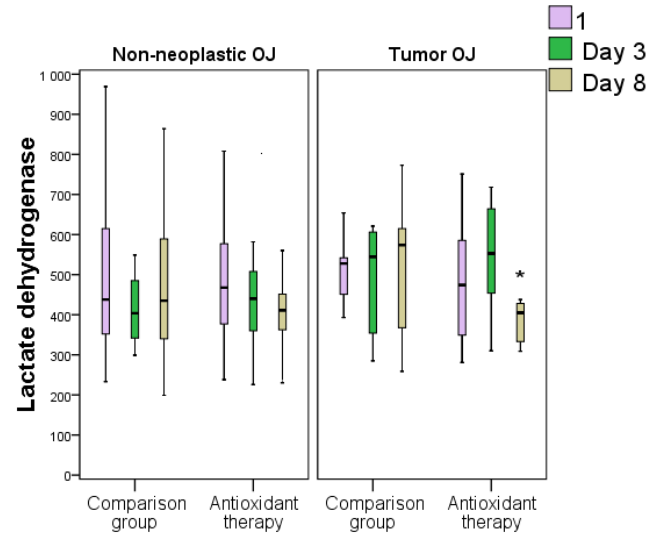
Figure 11. Dynamics of lactate dehydrogenase levels in blood plasma in obstructive jaundice of various origins following antioxidant therapy (*—difference between groups at p < 0.05, Mann– Whitney test). Abbreviations: OJ, obstructive jaundice.